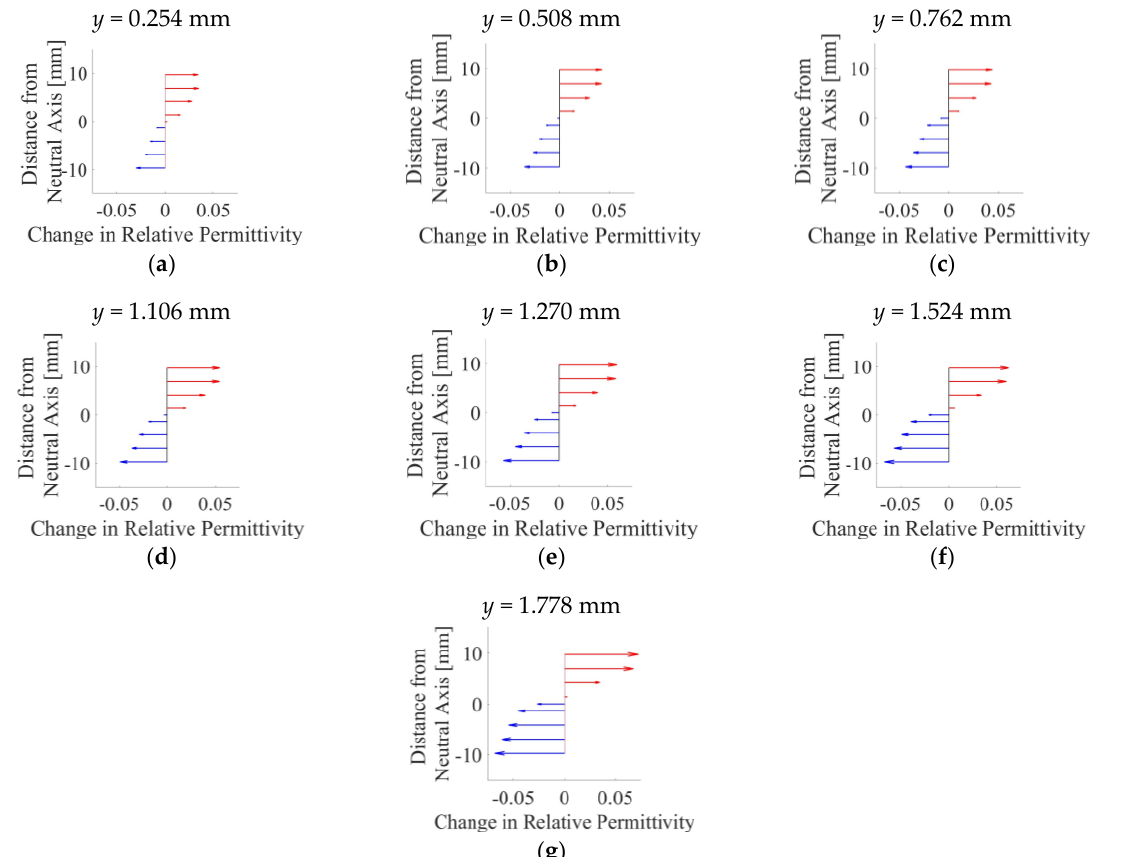
Figure 14. ( a ) A 25 mm-long, 2 mm-wide rectangular region was considered at the center of the sensing region and coincided with a portion of the OIP phantom. ( b ) The rectangular strip consisted of 18 triangular elements.